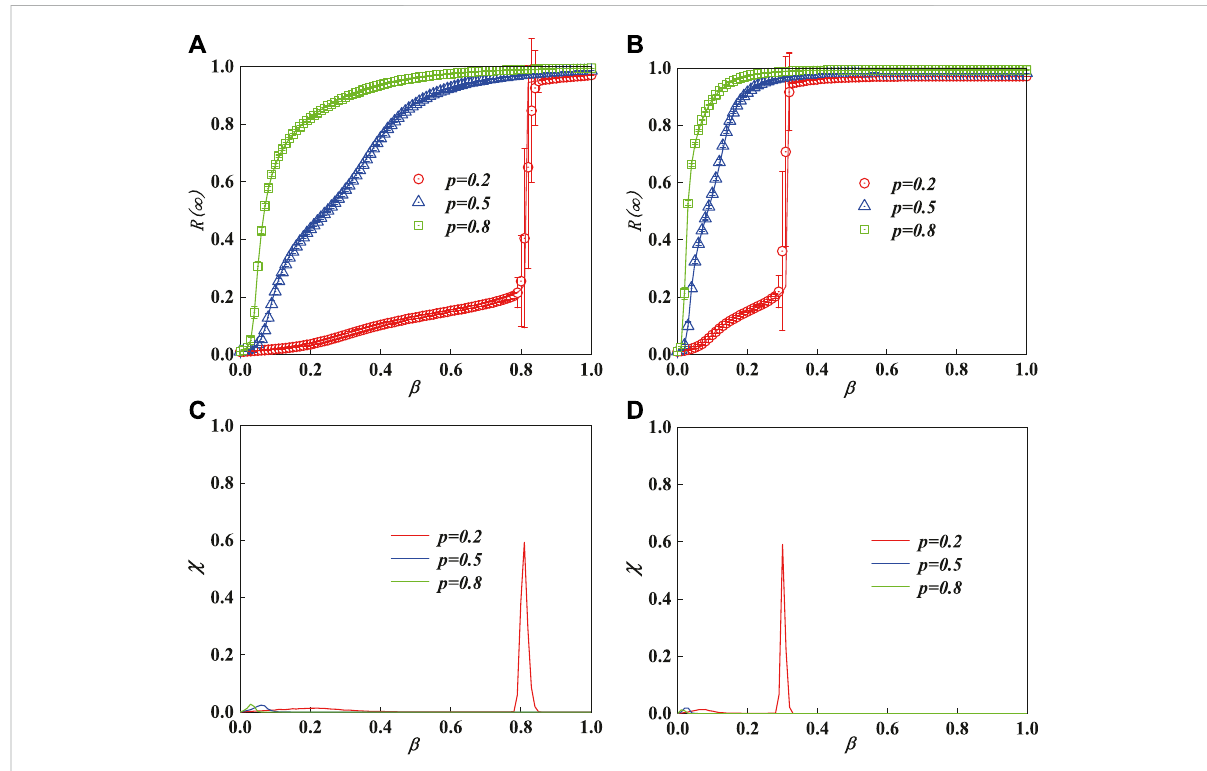
FIGURE 2 Unit propagation probability ’ s impact on the fi nal adaptive size of nodes in a weighted ER network with various percentages of active nodes, in beta. The phase transition is shown to be impacted by the heterogeneity of the weight distribution in (a1) ( α ω = 2) and (b1) ( α ω = 3). The relative variances and thresholds in subparagraphs (A) and (B) , respectively, are indicated in subparagraphs (C) and (D) . Additionally, the theoretical predictions (dotted lines) in subparagraphs (A,B) are in good agreement with the simulation results (symbols). Other parameters are ρ 0 = 0.01, T p = 1, and T q =